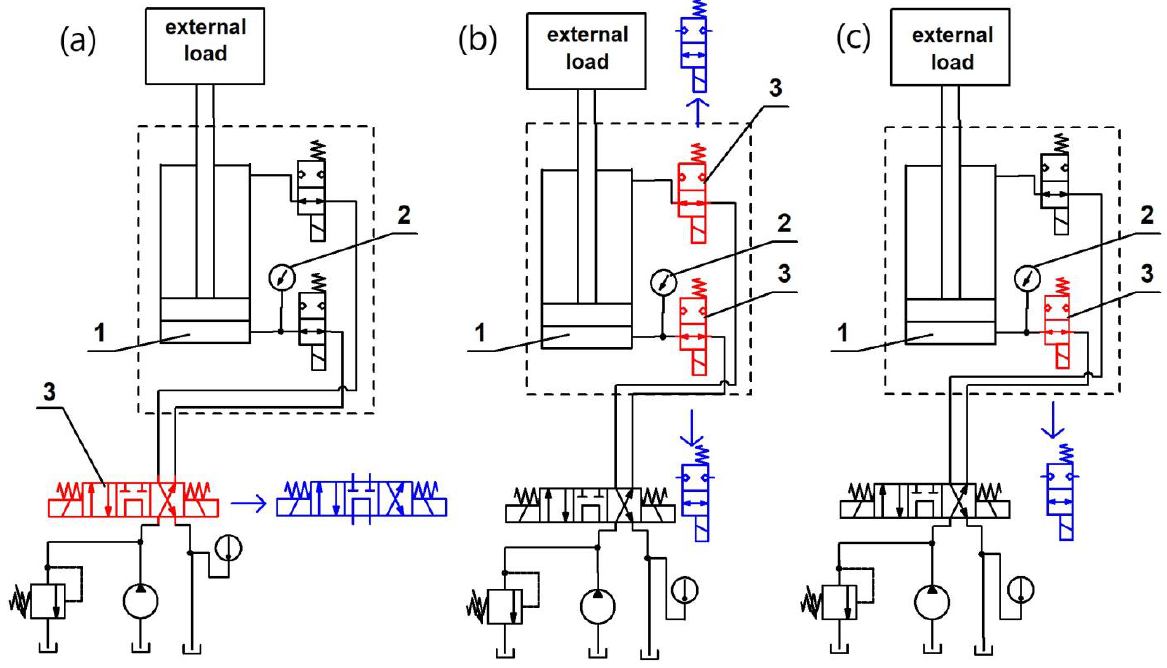
Figure 3. Simplified schematic diagram of the cylinder-stopping control systems: ( a )—employing a spool valve (first tested solution), ( b )—employing two directional control valves (second tested solution), ( c )—employing a single directional controlled valve (third tested solution); the controlled valves are indicated in red, the valves positions after initiating the stopping process are indicated in blue; no. 1 indicates the cylinder, no. 2 indicates the pressure transducer, and no. 3—the controlled valves. Table 1. Basic elements of the